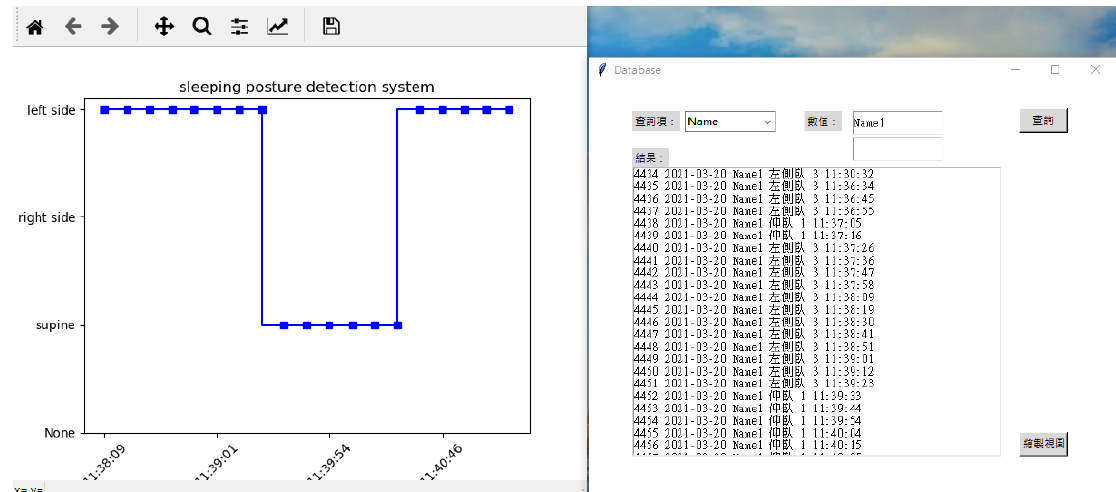
Figure 4. Terminal manager interface and GUI results of the PC terminal.